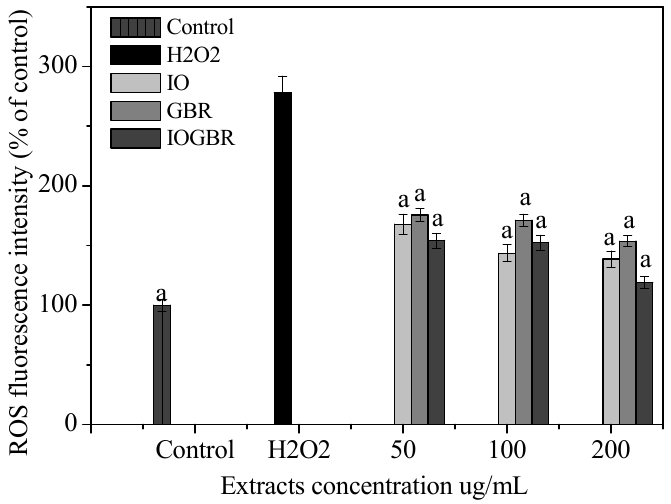
Figure 1. Effect of the extracts from Inonotus obliquus (IO), germinated brown rice (GBR) and Inonotus obliquus grown on germinated brown rice (IOGBR) on ROS production in H O -treated Chang liver 2 2